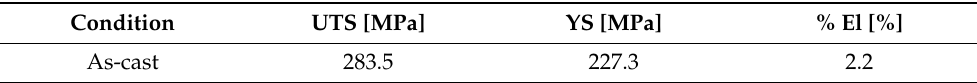
Table 4. Tensile properties of alloy